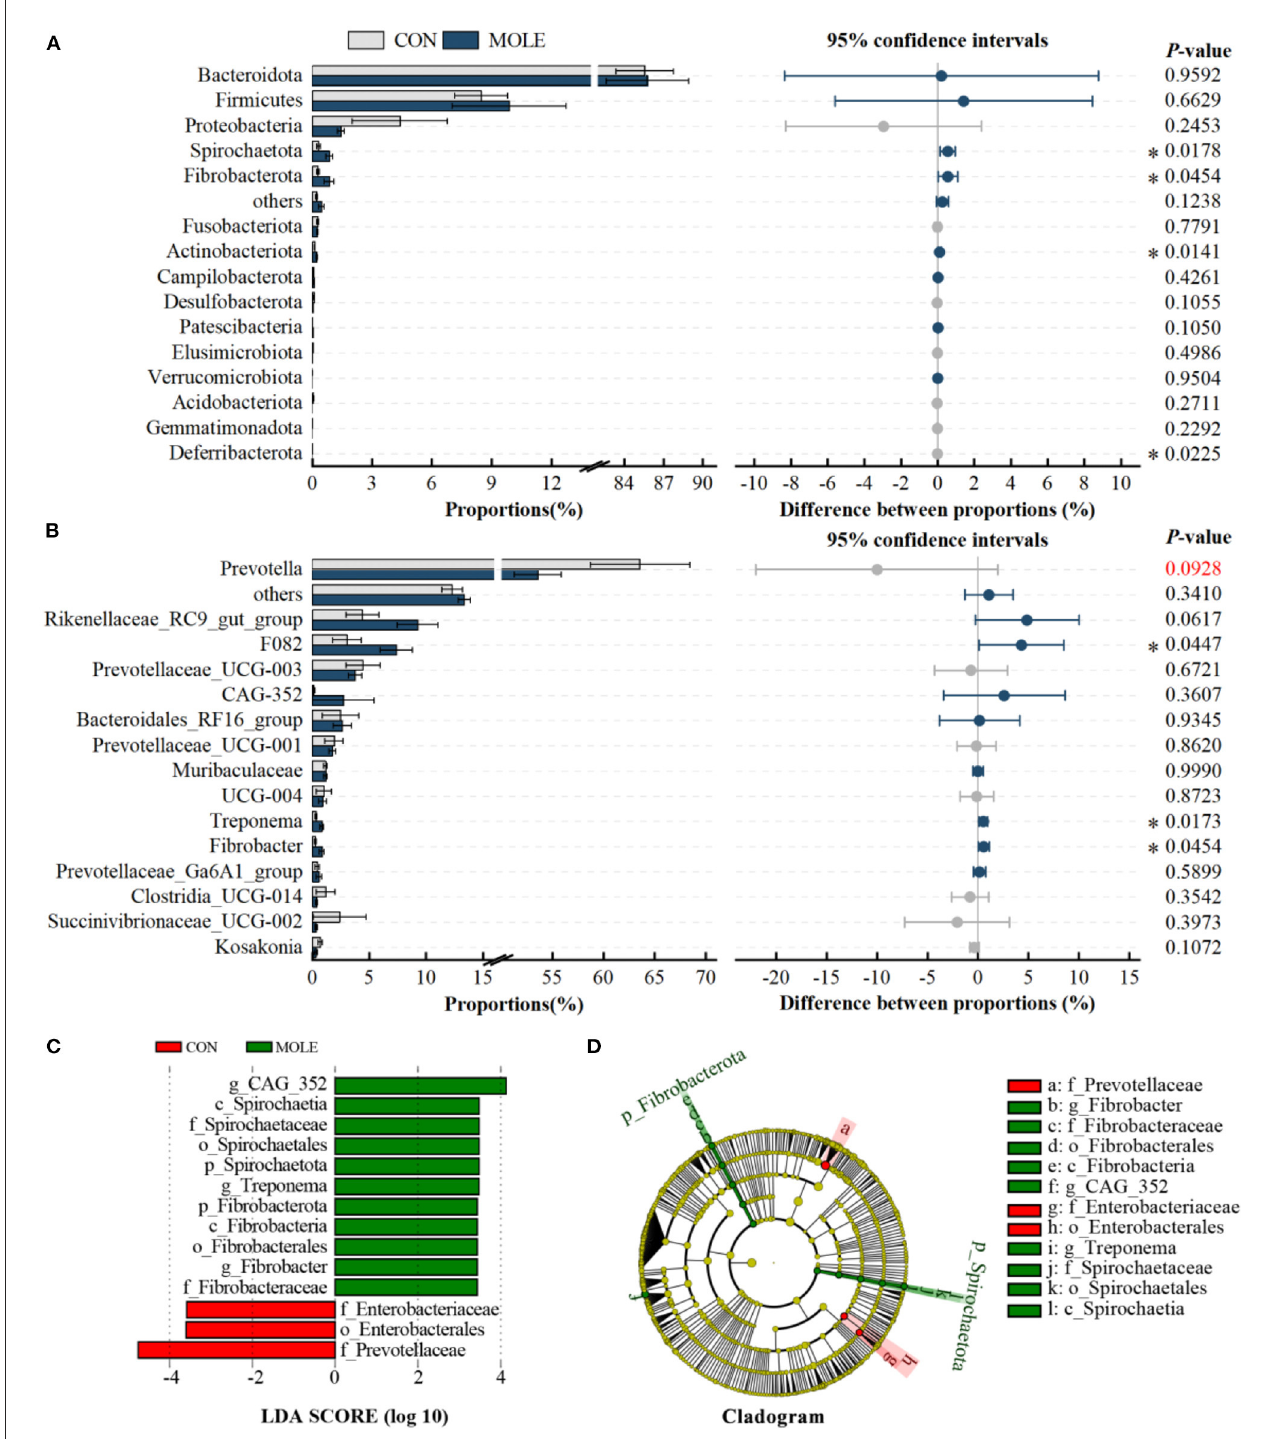
FIGURE3 Effects of MOLE on the rumen microbial composition. The difference between bacterial phyla (A) and genera (B) was tested by the Student’s t -test. The top 15 microbes’ average abundance was compared. (C) Linear Discriminant Analysis (LDA) coupled with effect size (LEfSe) measurements identifies the most differentially abundant taxa between CON and MOLE groups. Taxa enriched in the MOLE group are indicated with a positive LDA score (green), and taxa enriched in the CON group have a negative score (red). Only taxa with an LDA score of > 3 and a P value of < 0.05 are shown. (D) Cladogram for rumen microbiota (CON group vs. MOLE group). The values in the histogram are the mean values of relative abundance ± SEM. Trend for 0.05 < P < 0.1, and * P < 0.05.